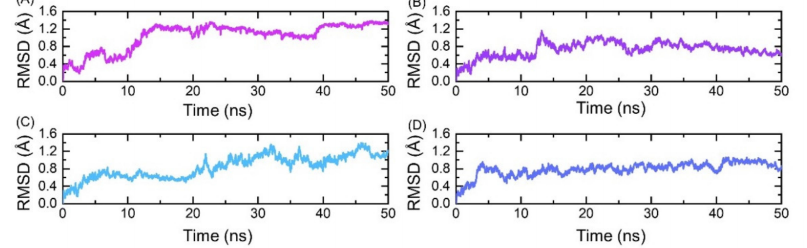
Figure 4. ( A ) Root mean square deviation of the best hit 1. ( B ) Root mean square deviation of the best hit 2. ( C ) Root mean square deviation of the best hit 3. ( D ) Root mean square deviation of the best hit